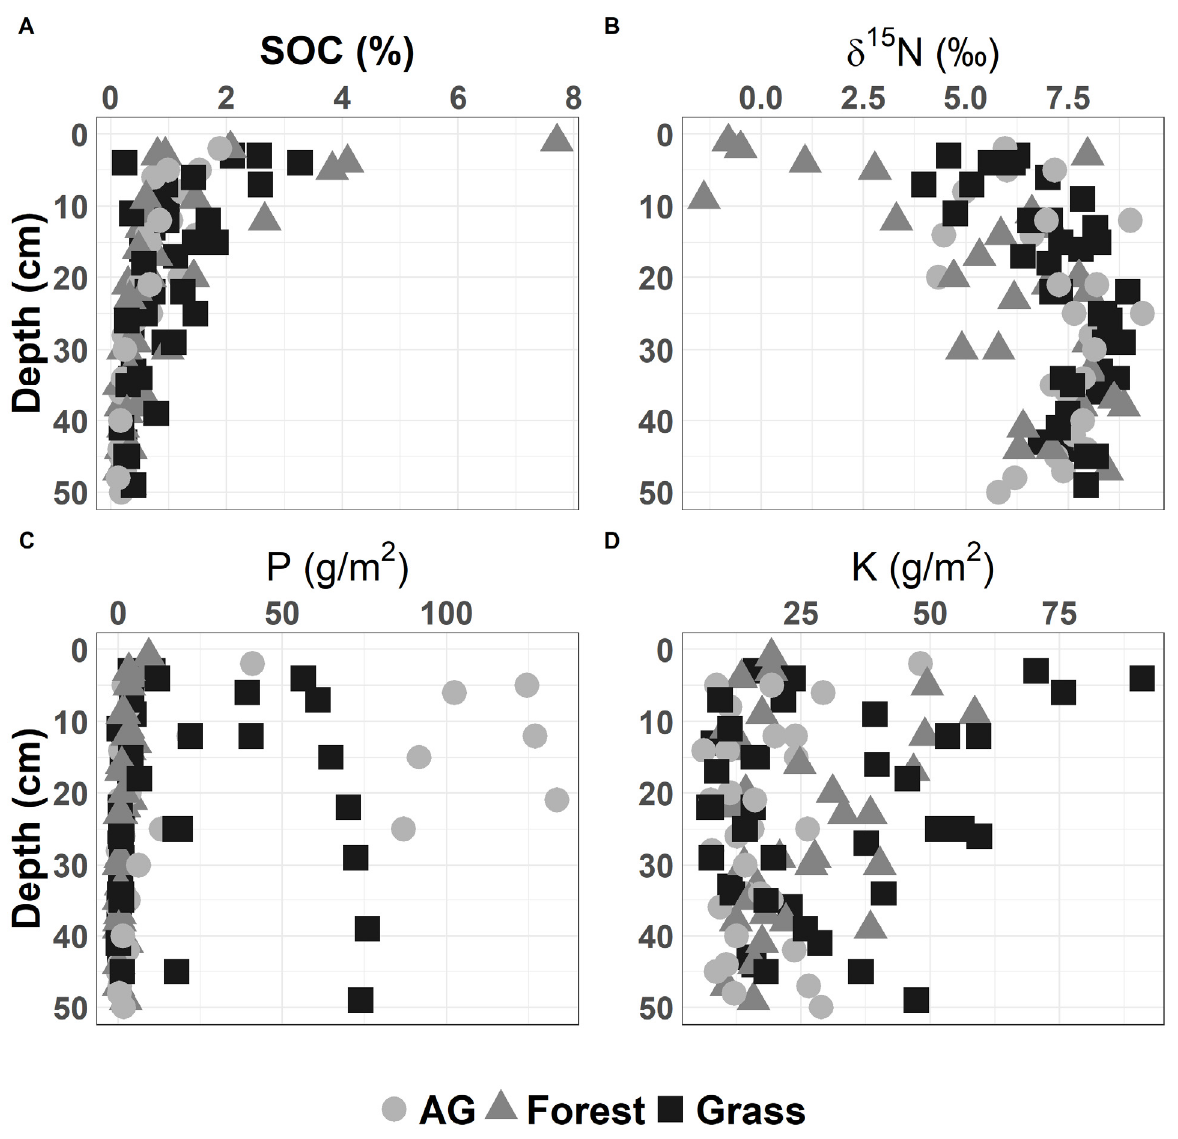
Figure 3. Variability of soil chemical properties with soil depth for the study sites: ( A ) total soil carbon (%); ( B ) δ 15 N; ( C ) extractable phosphorus (P); ( D ) extractable potassium (K).